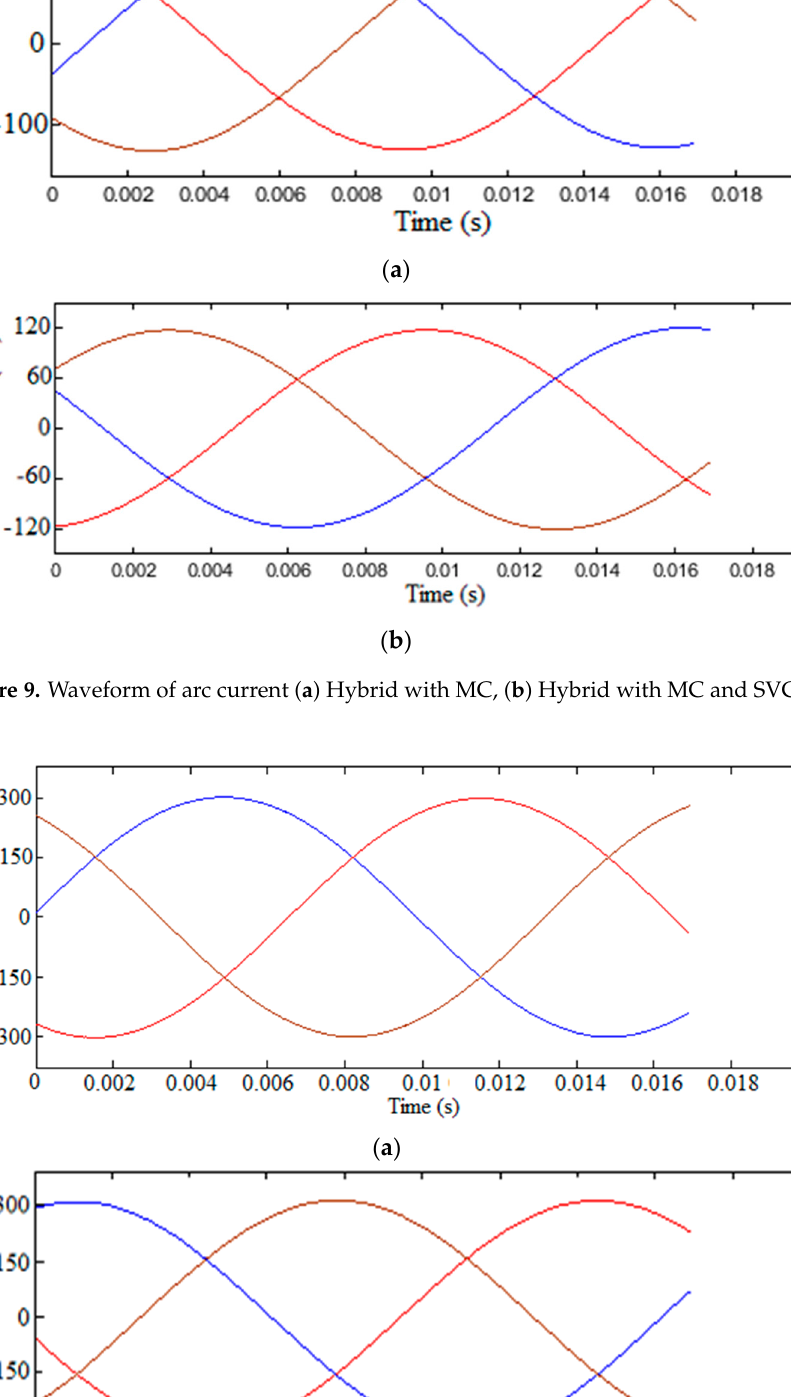
Figure 8. Voltage and current (input to MC).